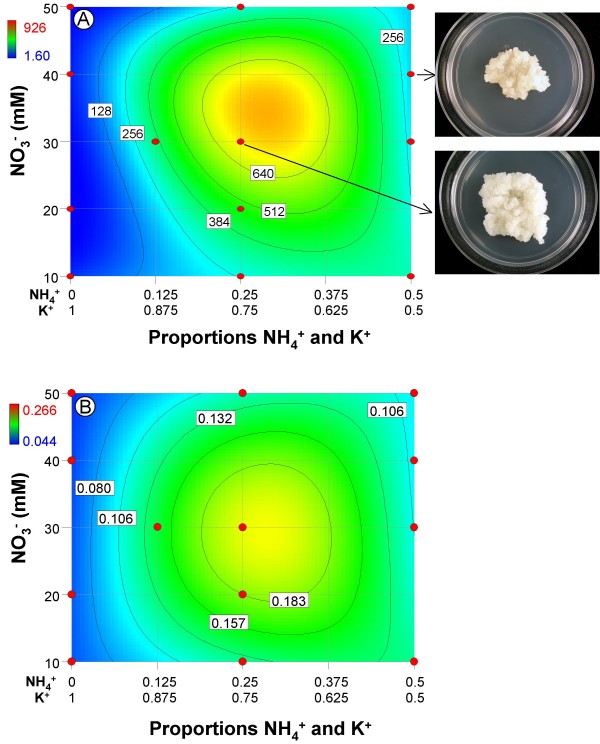
Fresh and dry weight response contour plots for nonembryogenic tissue. A) % increase in fresh weight growth; B) dry weight. Pictures of the difference in biomass between standard MS and the center point of the experimental design space are pictured to the right of each plot.